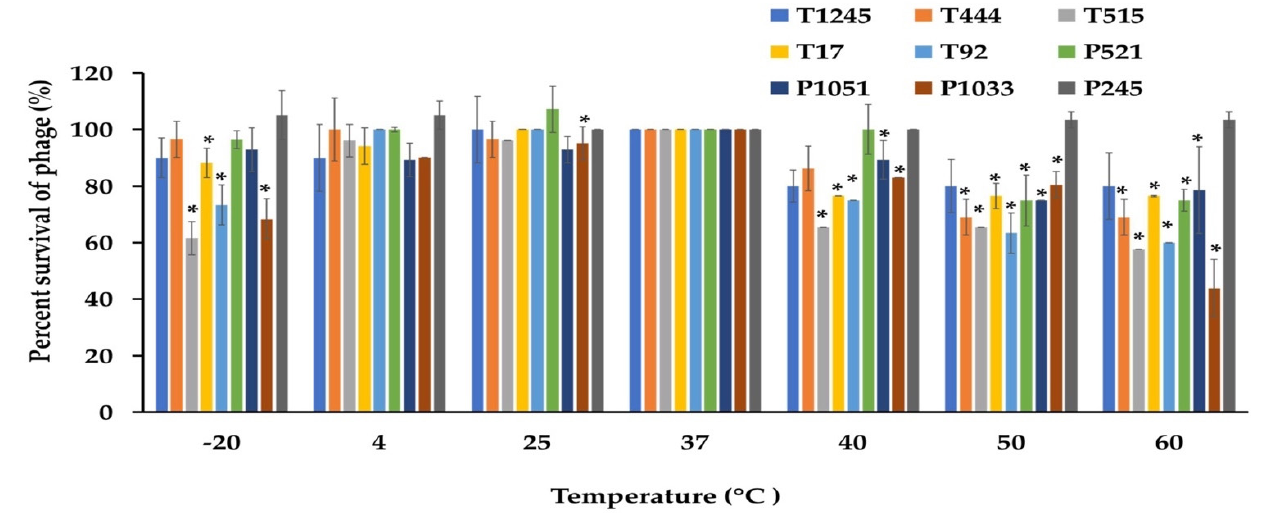
Figure 5. The stability of nine phages at various temperatures was measured for 2 h. The results were calculated as the percentage of surviving phage. Three independent experiments were performed in triplicate, and error bars represent the standard deviations (*, p < 0.05).